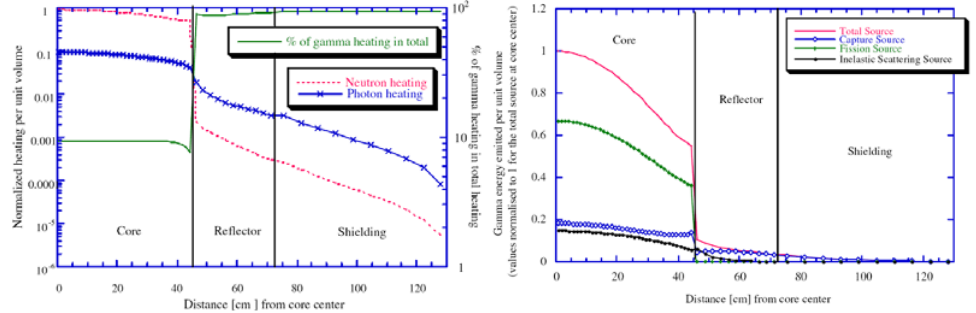
Fig. 1. Energy deposition in a Fast Reactor & Gamma heating relative contribution sources